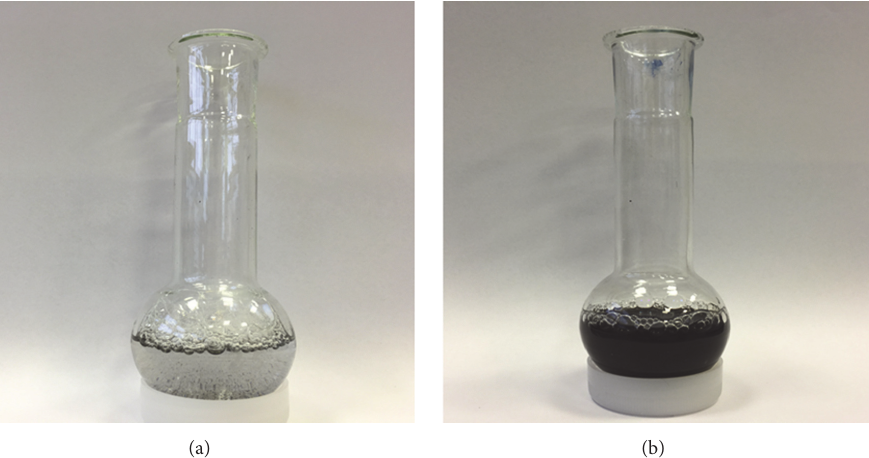
Figure 2: Slurries of examined materials (CeZrO 2 /CNT): (a) before dispersion in Triton X-100 solution; (b) after dispersion in Triton X-100 solution with